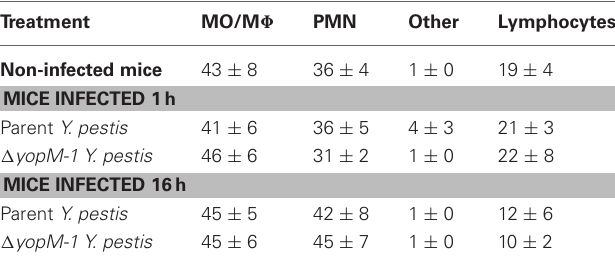
Table 2 | Distribution of cell types among splenic CD11b + cells analyzed by multiplex chemokine/cytokine